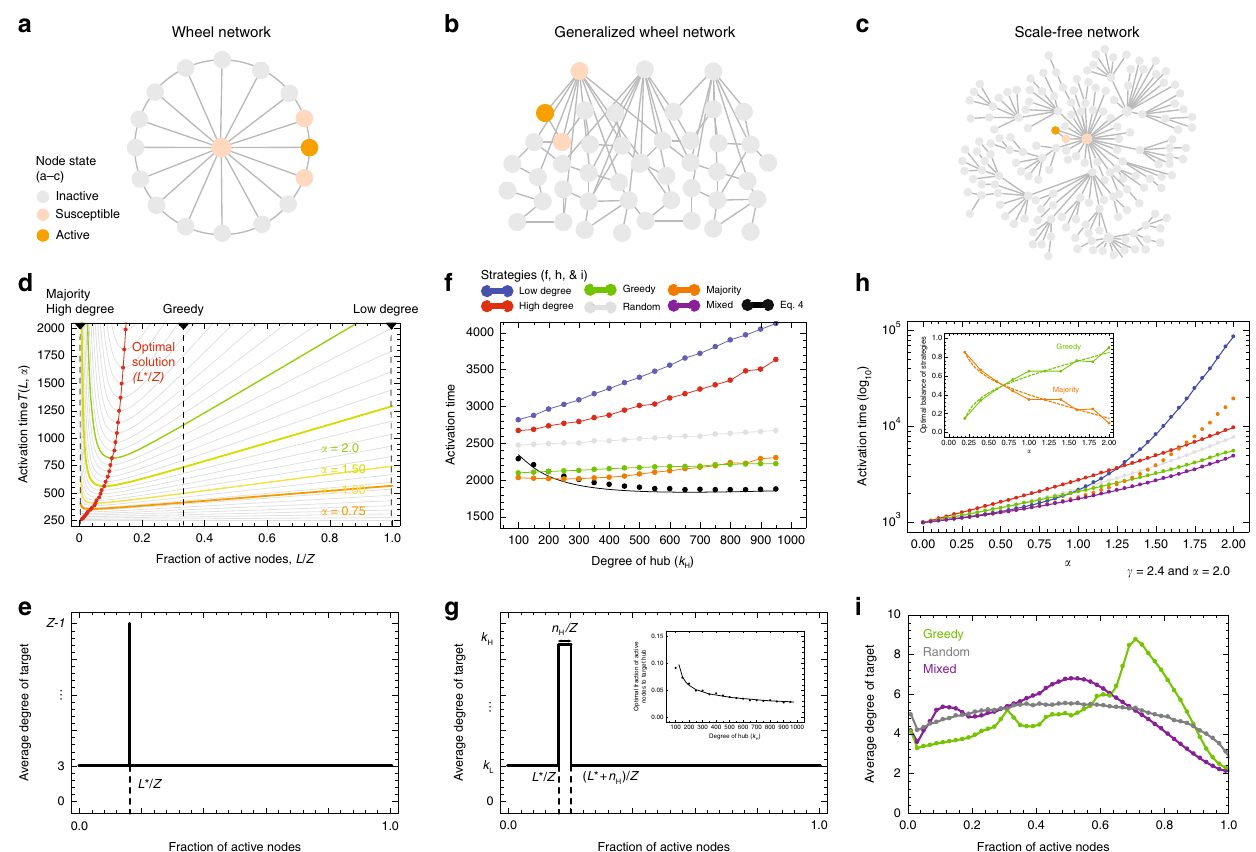
Fig. 2 Strategic diffusion in networks. Network models. a Wheel network, b generalized wheel network, and c scale-free network. d Time needed to activate all nodes in the wheel network as a function of the time in which the hub is targeted, with time expressed as the fraction of active nodes (Eq. 2). Optimal time is indicated with the red line. e optimal strategy for the wheel network described as the degree of the nodes that is optimal to target for each fraction of the total nodes that have been activated. f Total time needed to activate a generalized wheel network as a function of the degree of hubs for the fi ve simple strategies and for the solution of Eq. 4 (in black line, black dots represent a simulation). g optimal strategy for the generalized wheel network described as the degree of the nodes that is optimal to target for each fraction of the total nodes that have been activated. Inset shows optimal targeting time as a function of the degree of the hubs. h Total activation time to activate a scale-free network for the fi ve pure strategies and the optimal mixed strategy as a function of the parameter modeling the importance of relatedness α . Inset shows optimal mix of greedy and majority strategies as a function of α . i Dynamic strategies for the scale-free networks obtained via numerical simulations for the greedy, random, and the optimal mixed strategy. The mixed strategy targets hubs at an intermediate